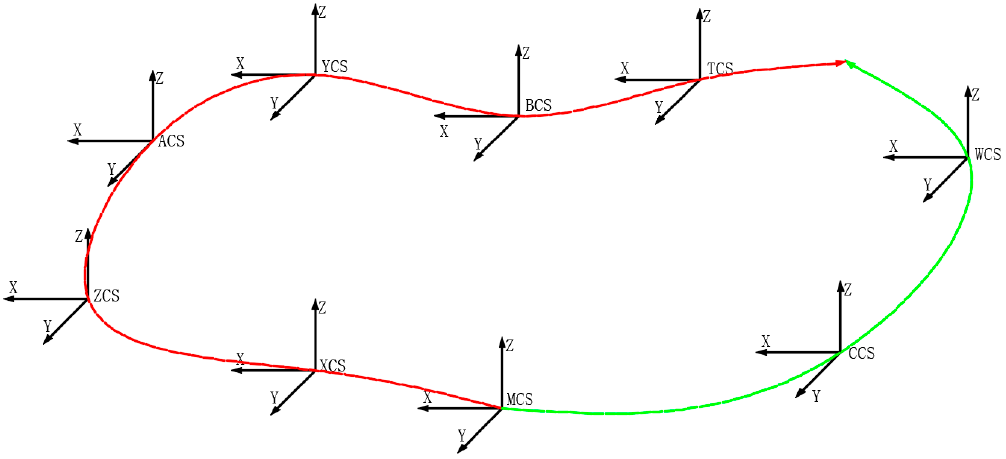
Figure 12. Geometric error transfer route.